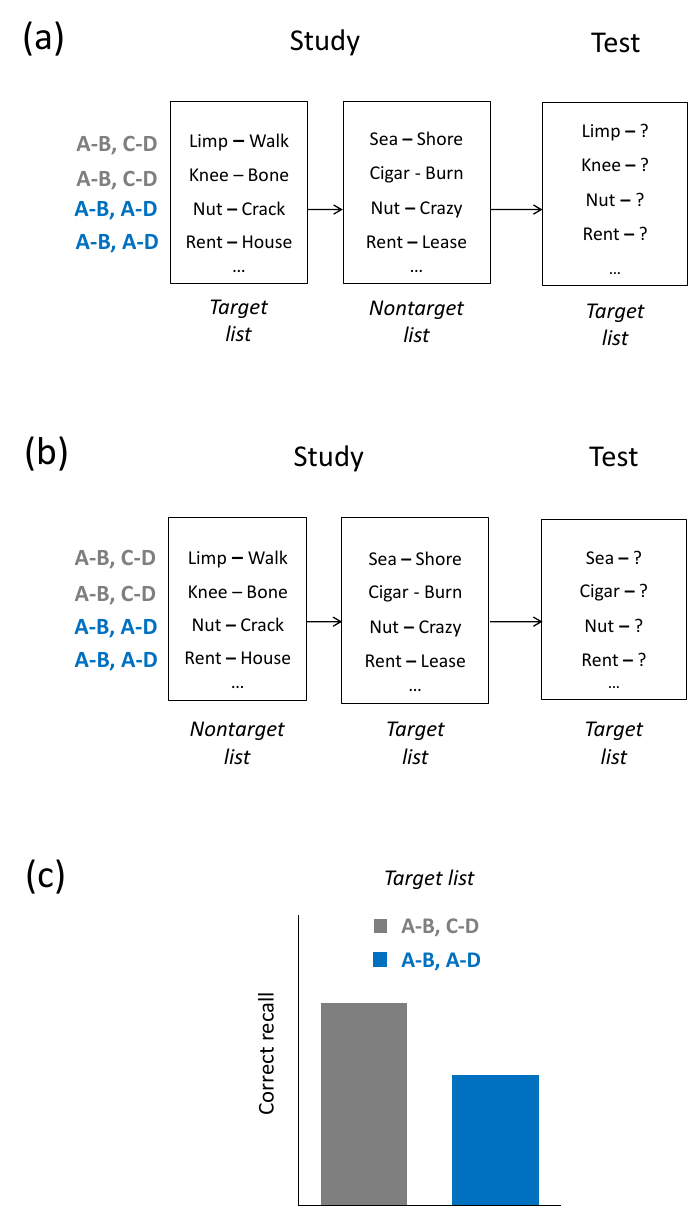
Figure 1. Paired-associate learning. ( a , b ) Retroactive-interference version ( a ) and proactive- interference version ( b ) of the task: Participants study a target list of stimulus–response pairs that is either followed ( a ) or preceded ( b ) by a list of other (nontarget) pairs. In both versions of the task, the second list consists of two types of word pairs: non-overlapping, new pairs for which neither the stimulus word nor the response word had appeared in the nontarget list (A-B, C-D); and overlapping pairs for which the stimulus word had already appeared in the nontarget list but the response word is new (A-B, A-D). ( c ) Typical results: In both the retroactive-interference and proactive-interference versions of the task, recall of the target list in A-B, A-D pairs is typically impaired relative to A-B, C-D